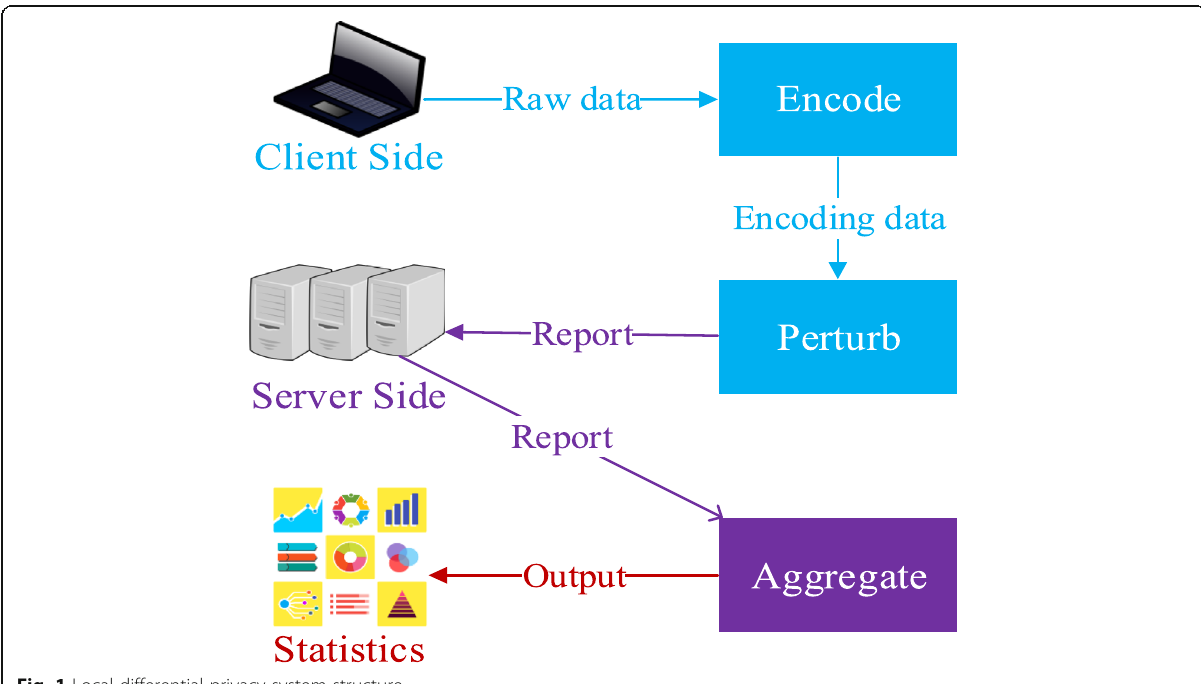
Fig. 1 Local differential privacy system